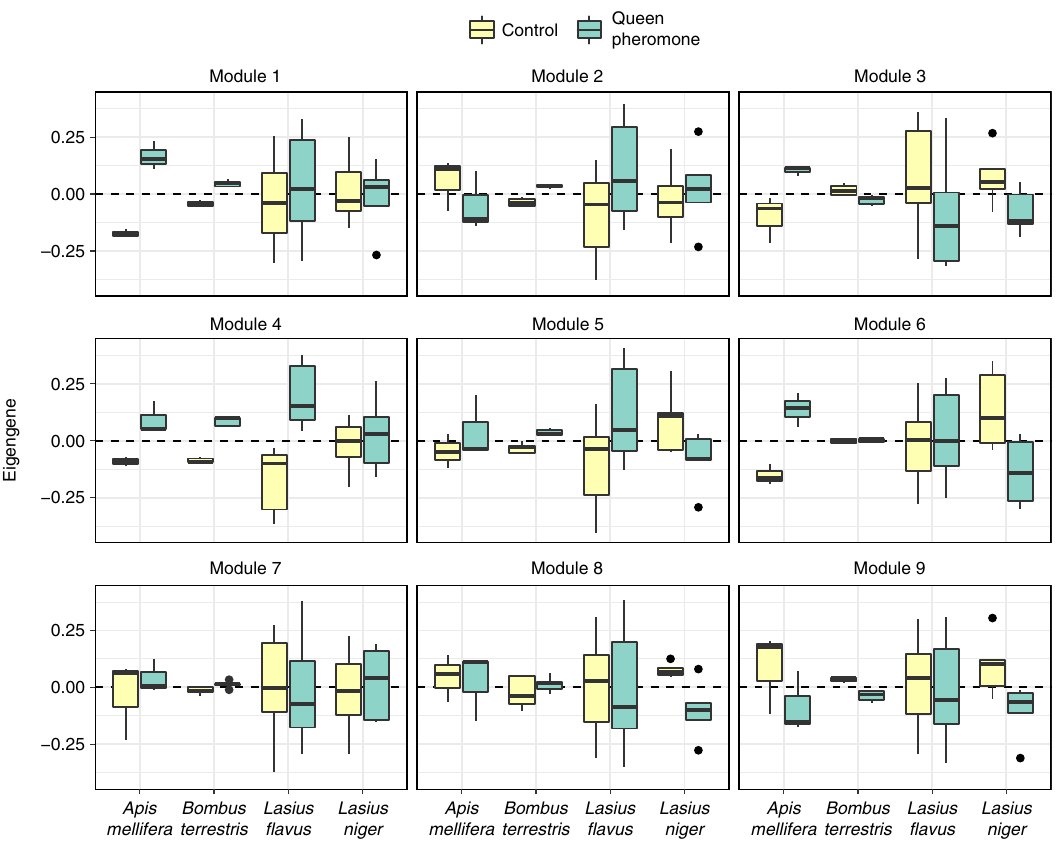
Fig. 3 Boxplots showing the distribution of ‘ eigengenes ’ across samples for each of the nine transcriptional modules identi fi ed by WGCNA. The eigengene is a measure of the expression level of a transcriptional module, relative to other samples in the set. Queen pheromone treatment had a statistically signi fi cant effect across species for modules 1, 4 and 9 (the annotations give Cohen ’ s d effect size and its 95% CIs, estimated from a multivariate Bayesian model of all nine modules). The boxes show the median and interquartile range, and the whiskers mark the furthest data point within 1.5× the interquartile range of the edge of the boxes (green: queen pheromone treatment, yellow: